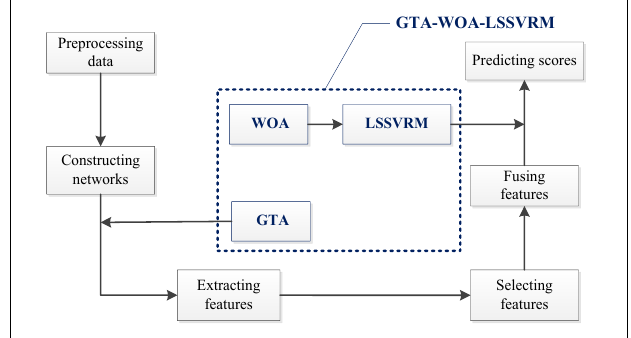
FIGURE 1 | Research